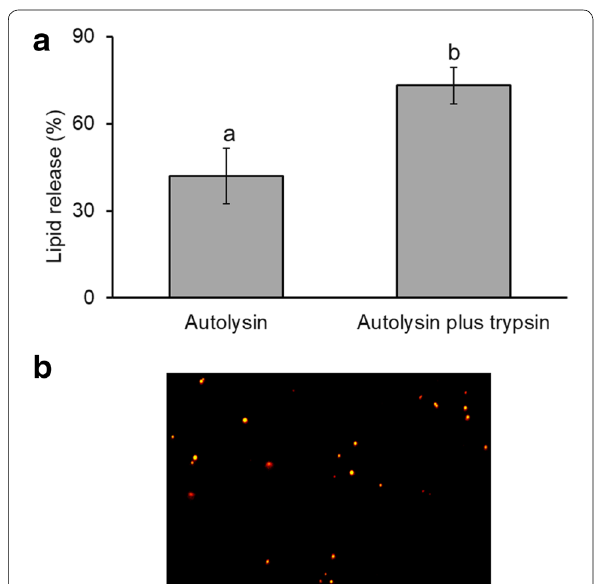
Fig. 5 a Total lipid percent (DW) of the supernatants after incubation with TAP‑N (control), autolysin, and autolysin plus trypsin. b Fluorescence microscopy imaging of lipids (yellow fluorescence) stained with Nile Red. Error bars represent standard error for n > 3. Significant differences were corrected for multiple comparisons with Tukey adjustment and an α FER 0.05. Different letters represent = significant difference between